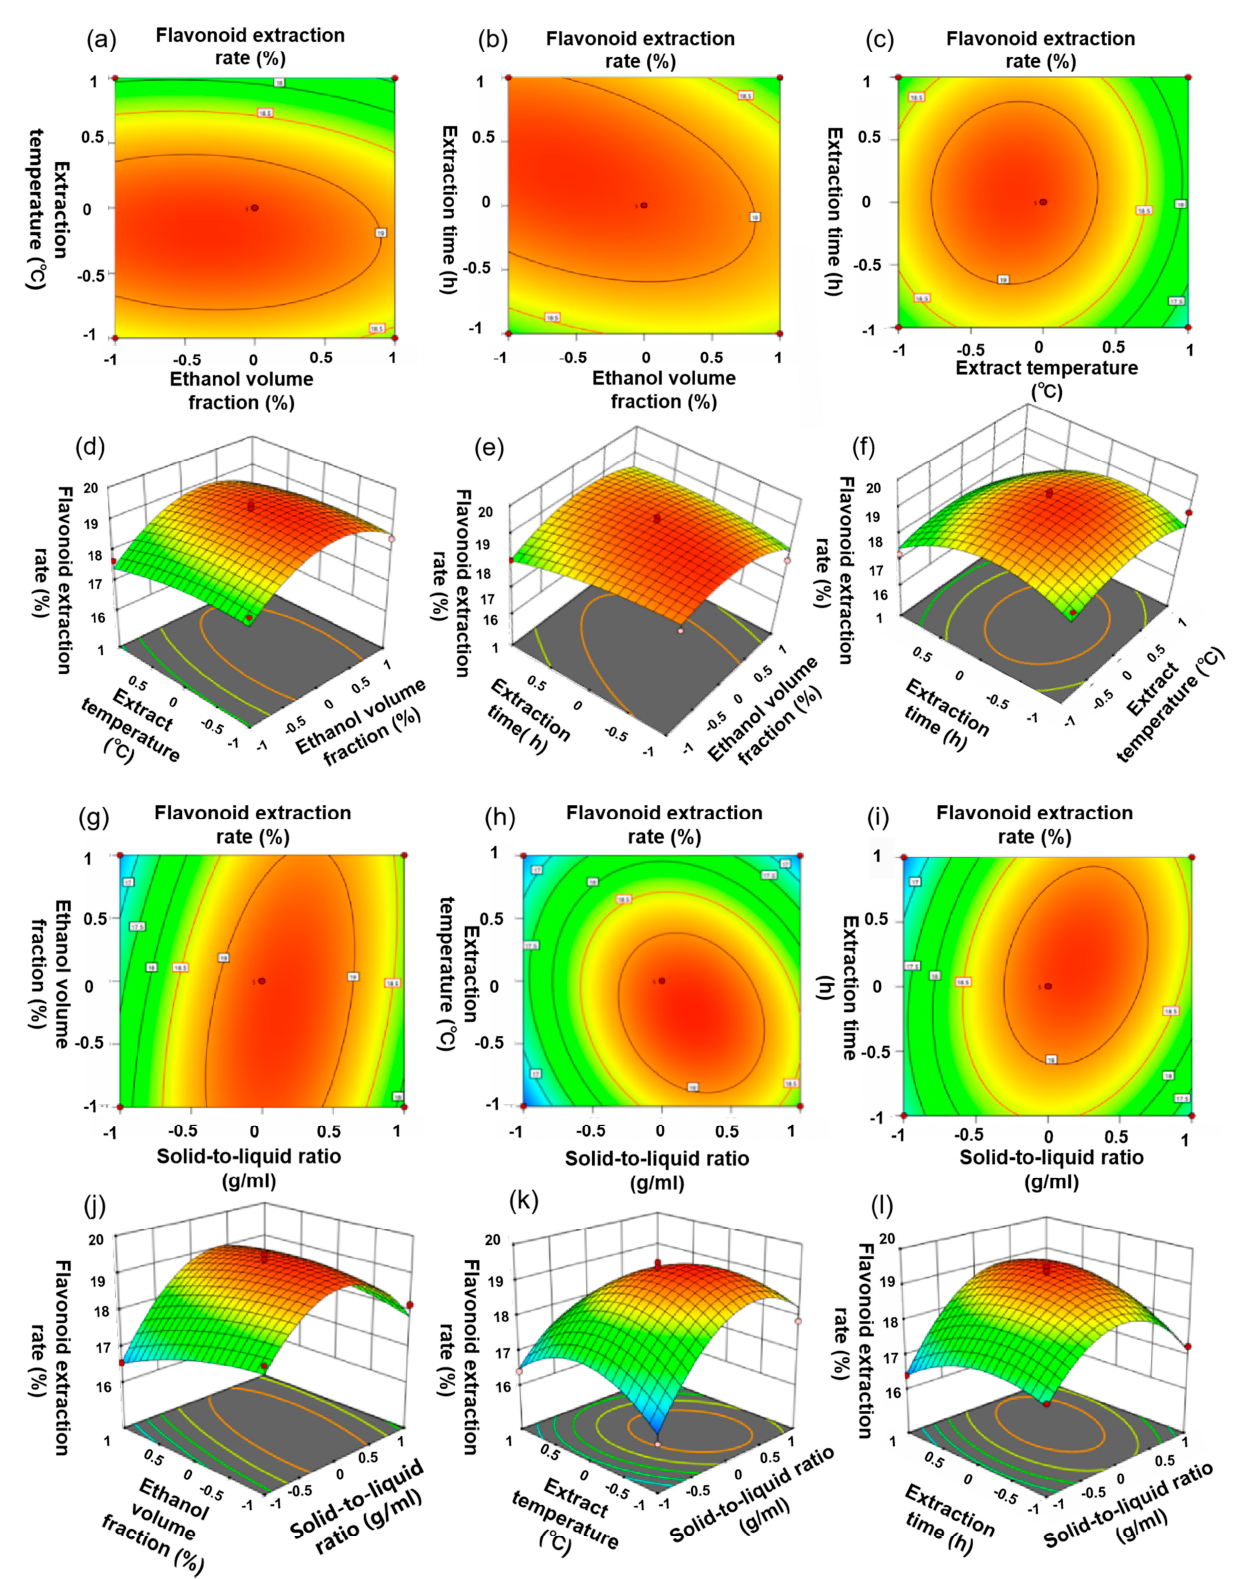
Figure 2. ( a – c , g – i ) represent the isoline map with significant interaction of extraction parameters; ( d – f , j – l ) represents the interaction of four factors affecting the extraction rate of BMF using response surface methodology.